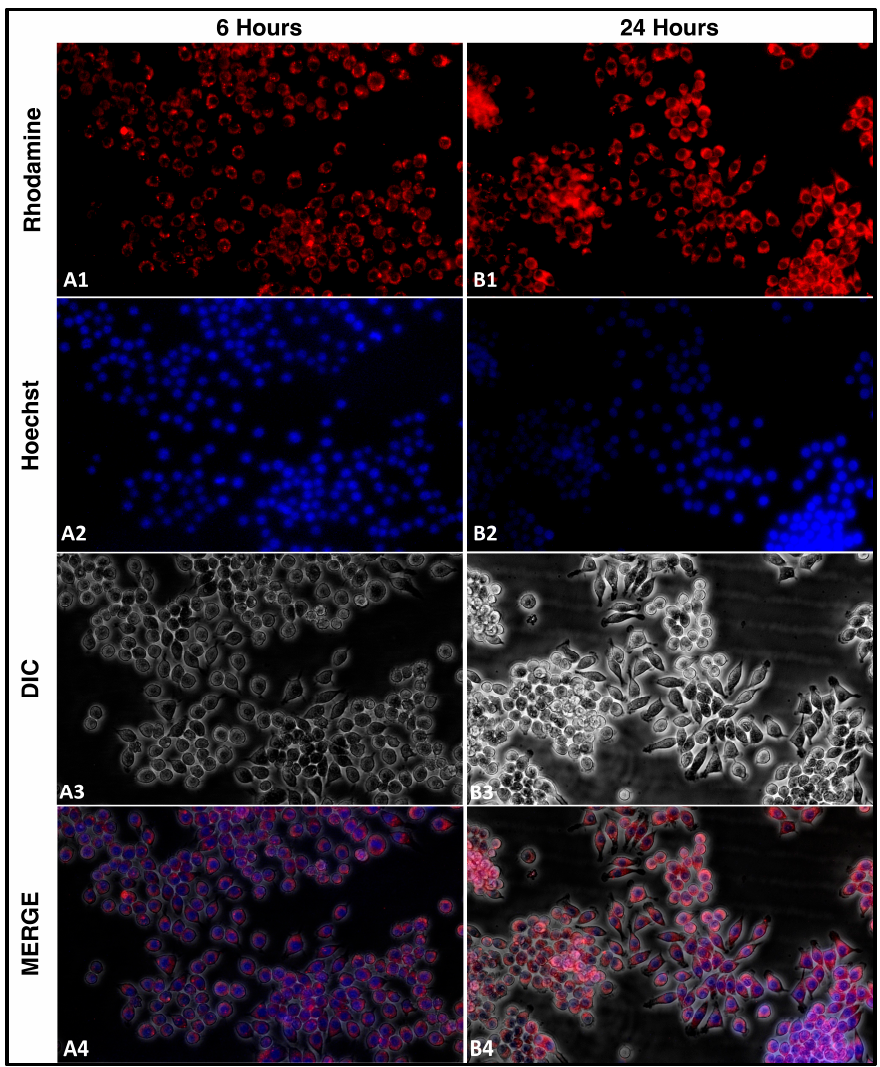
Figure 4. Cellular uptake of the rhodamine-tagged NLCs. ( A ) represents images captured at 6 h, while ( B ) represents images captured at 24 h. ( A1 ) Indicates the Rh-NLCs intensity after 6 h. ( B1 ) Increased intensity of Rh-NLCs at 24 h increased higher uptake of Rh-NLCs. Similarly ( A2 , B2 , A3 , B3 ) indicate the uptake of Rh-NLCs at 6 h and 24 h respectively, the images signify high uptake at 24 h. ( A4 ) Merged image indicating uptake at 6 h, subsequently the ( B4 ) Merged image with the increased intensity signifying high uptake of the Rh-NLCs at 24 h. (Magni fi cation 10 × ).